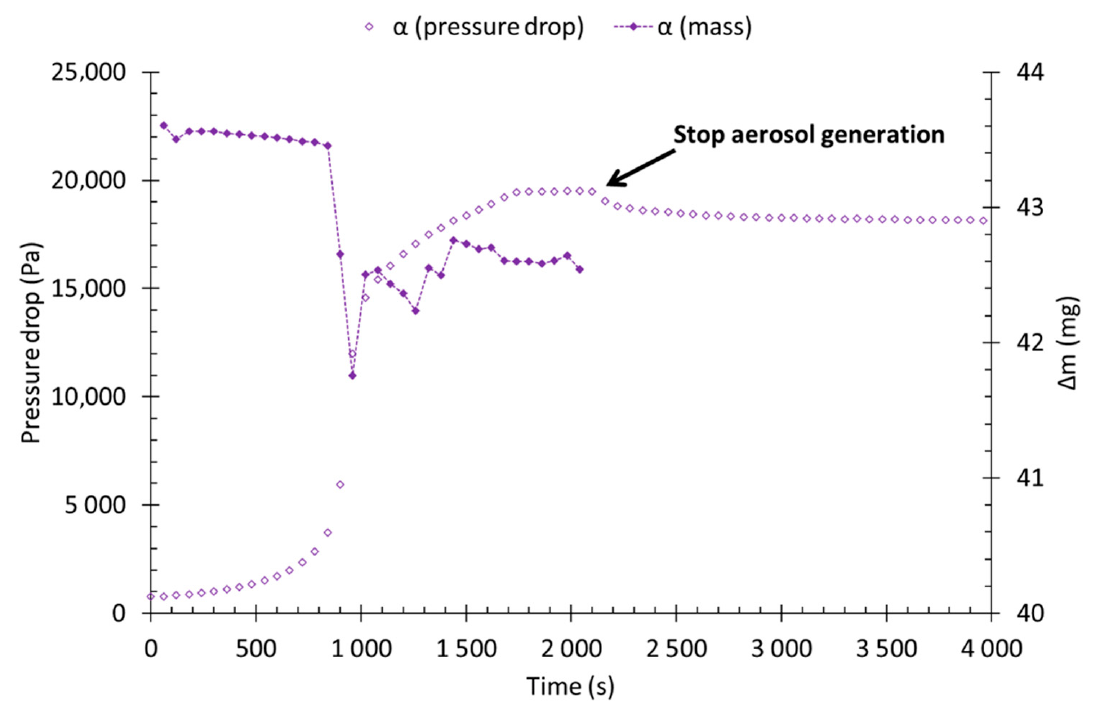
Figure 10. Pressure drop and mass evolution, before and after the aerosol stop, as a function of time, for filter α (at 6 cm/s).